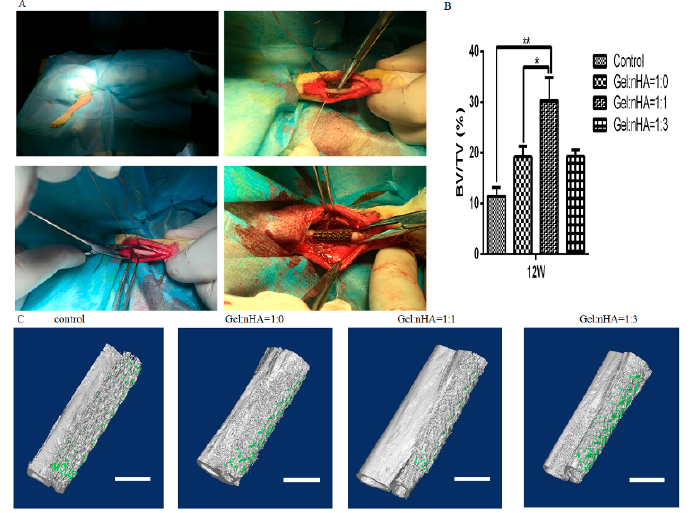
Figure 5. Surgical procedure and bone formation effects of different scaffolds. ( A ) surgical procedure; ( B ) BV/TV calculated by the CTAn software (Bruker Co. Kartuizersweg, Kontich, Belgium); ( C ) the volume of regenerated bone reconstruction based on ex vivo micro-CT scans at 12 weeks. Scale bar: 4 mm. * p < 0.05, ** p < 0.01.